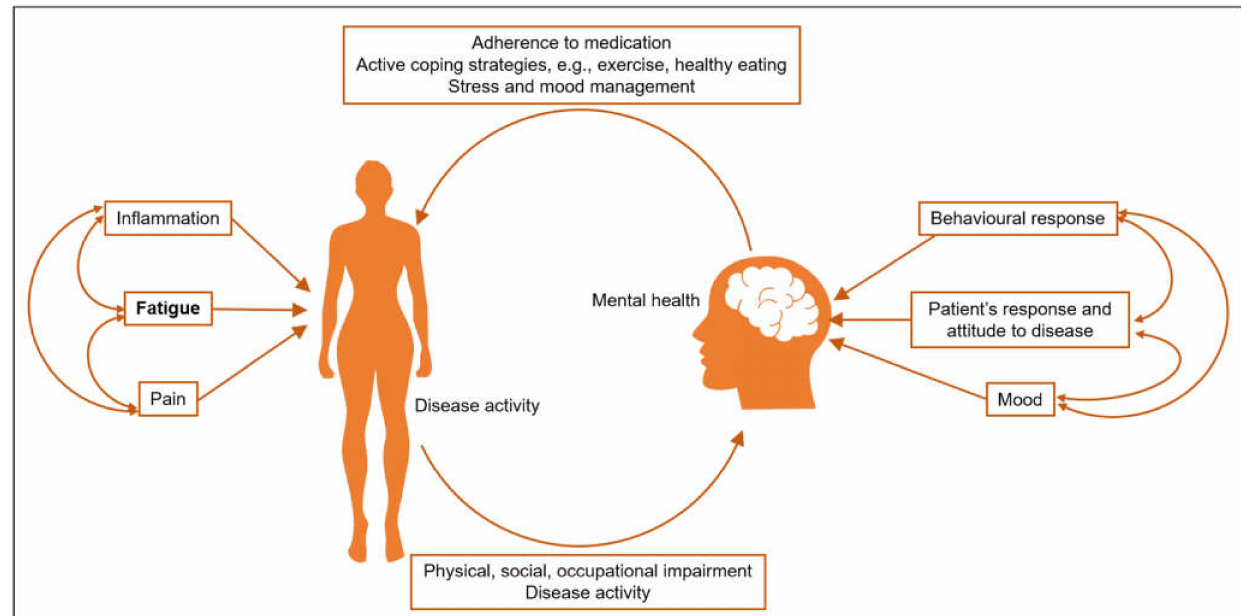
Figure 2. The relationship between fatigue and mental health in rheumatic diseases